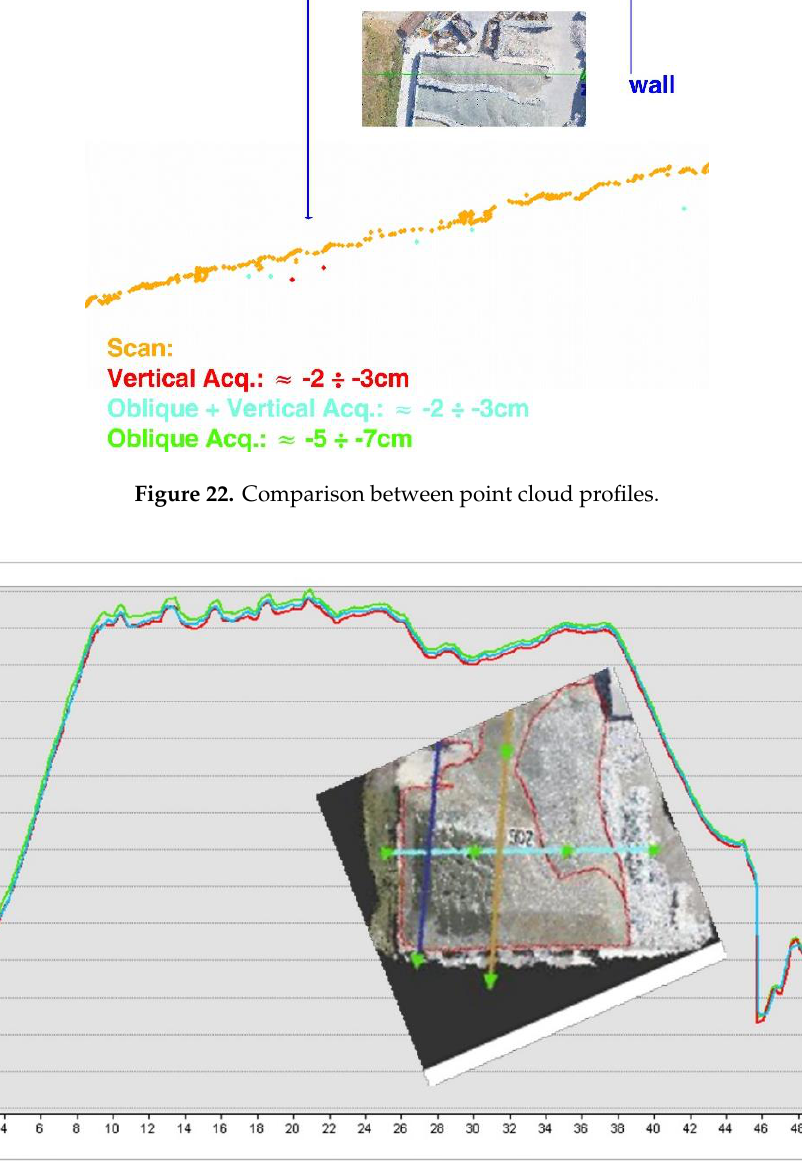
Figure 23. Photogrammetric DEM profiles in volume “6”.